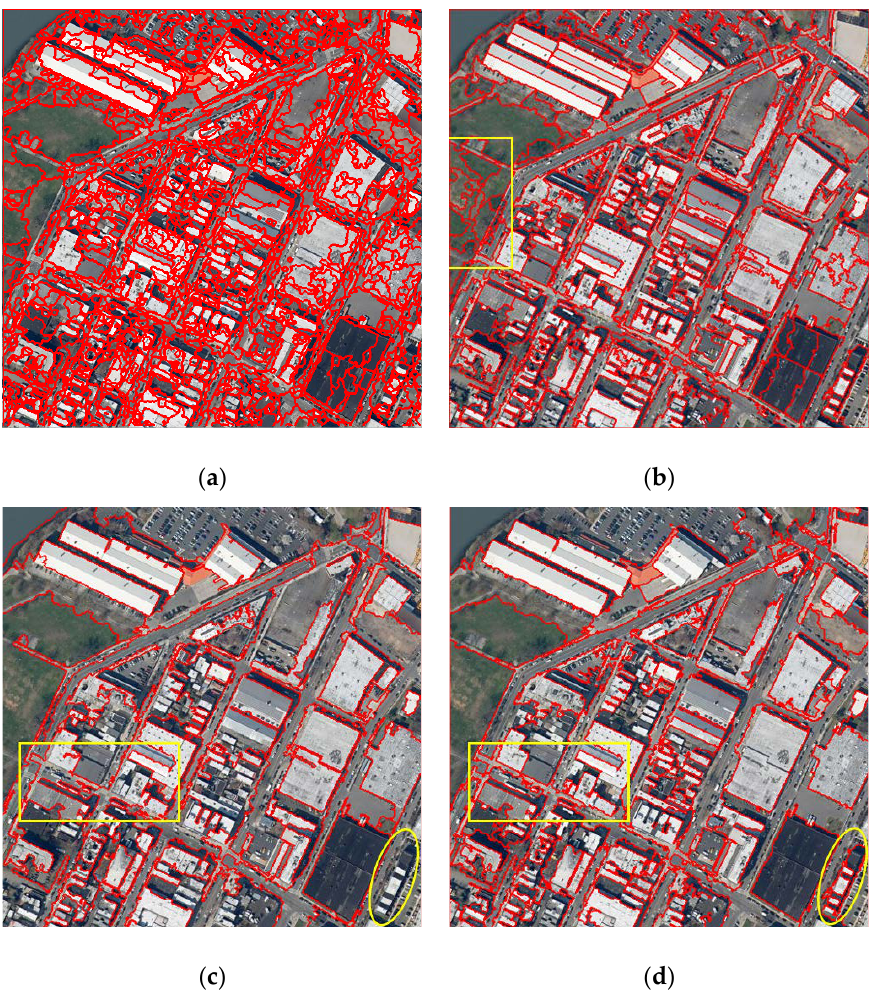
Figure 10. Segmentation results produced by different methods for the Manhattan aerial image (T2): ( a ) WTS; ( b ) MS; ( c ) MRS; ( d ) MMHS. Table 6. The quantitative assessment results of the Manhattan aerial image (T2).